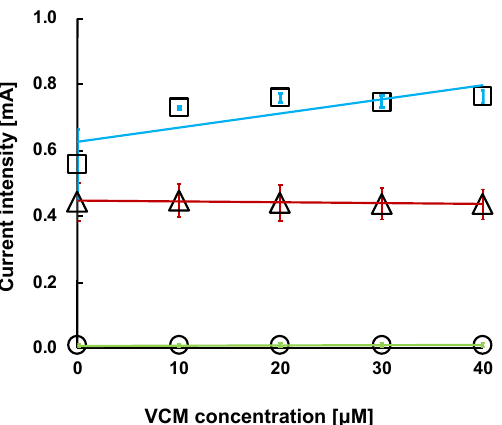
Figure 8. Relationship between the peak oxidative current of 5 mM ferrocyanide and VCM concen- tration at CV with MIP electrodes using ACPF (red triangle), that without ferrocenyl monomer (green circle) and unmodified ITO electrode (blue square).